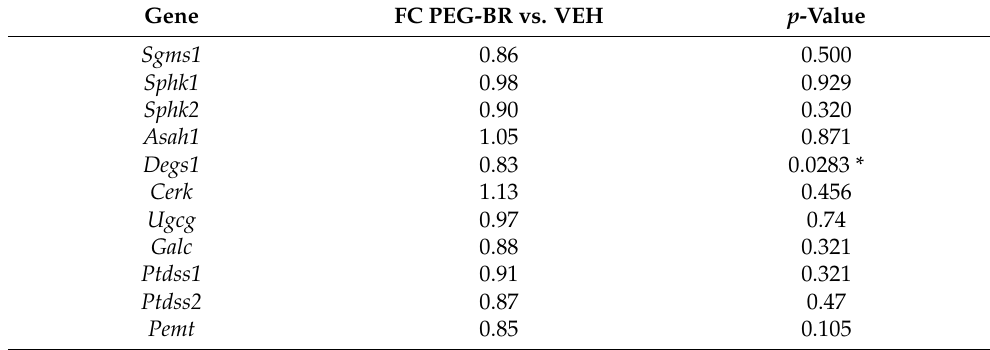
Table 2. Cont. Gene FC PEG-BR vs.